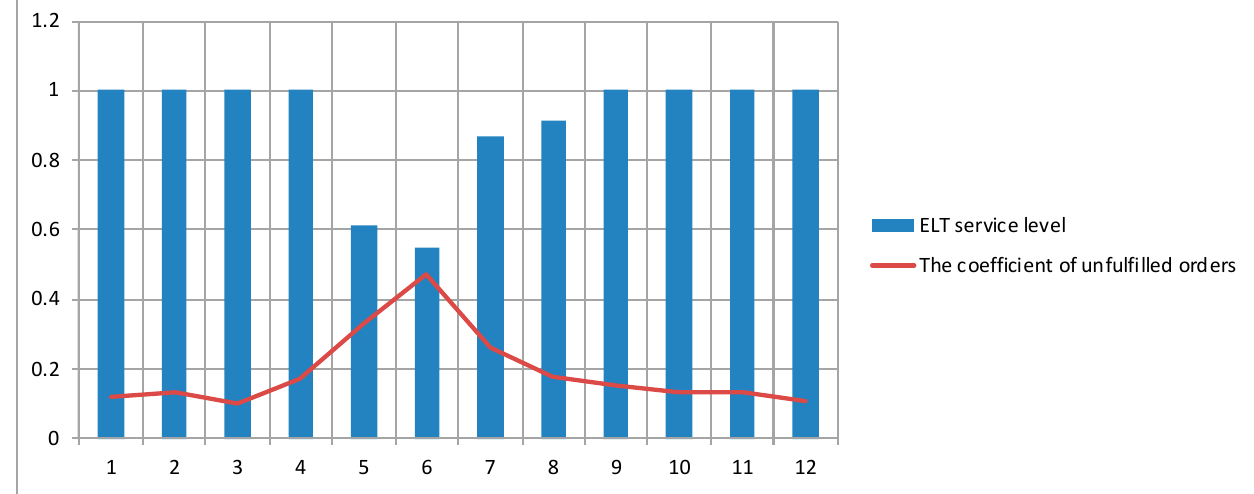
Figure 5. The dynamics of service indicators in the supply chain as a result of the occurrence of the risk event “fire in the DC”.